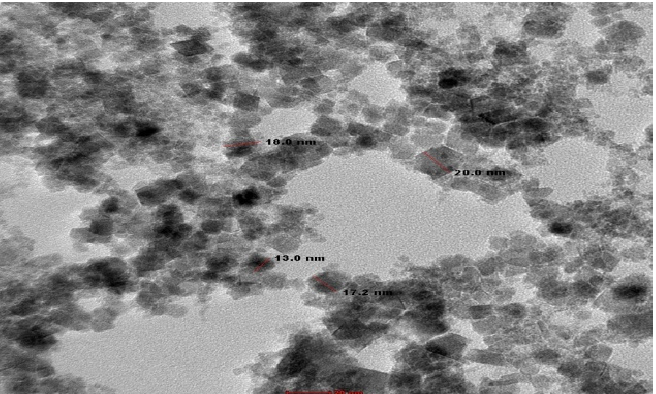
Figure 1. TEM imaging of the prepared magnetite nanoparticles revealed spherical shape of particles, with an average size of 9–14 nm.